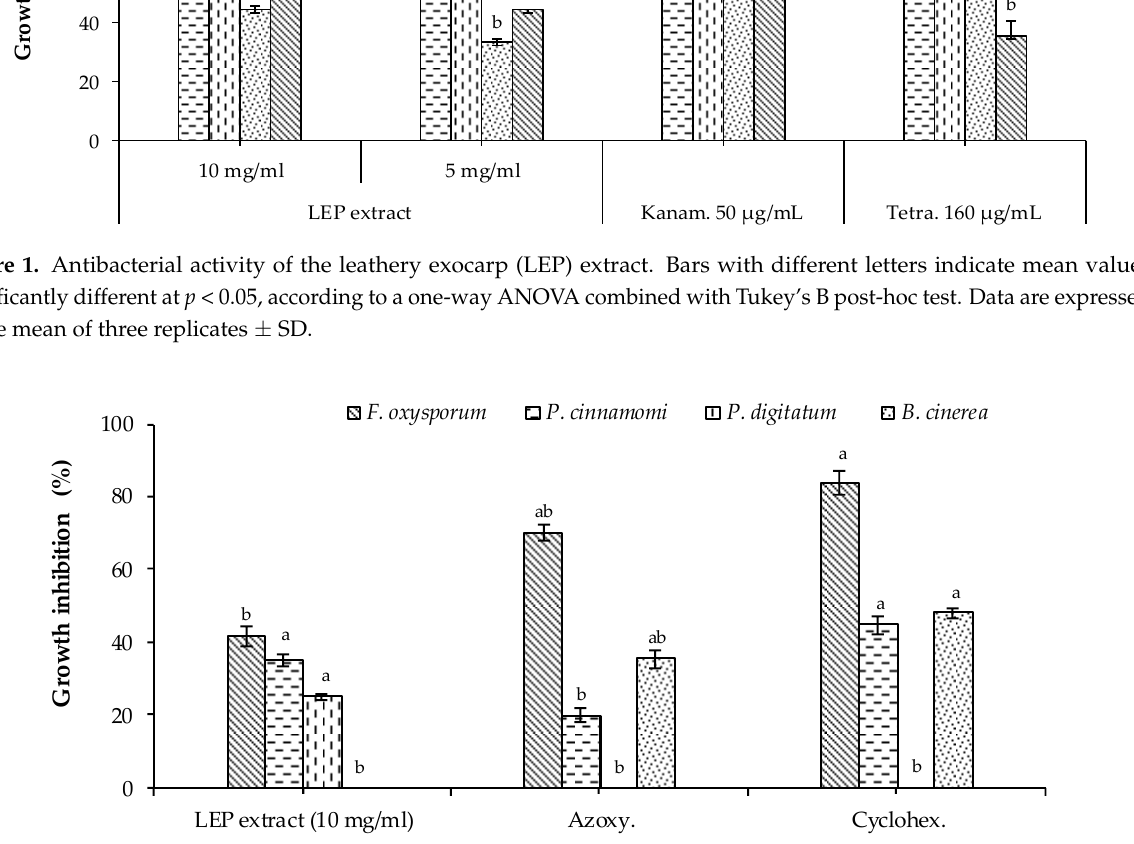
Figure 1. Antibacterial activity of the leathery exocarp (LEP) extract. Bars with different letters indicate mean values sig ‐ nificantly different at p < 0.05, according to a one ‐ way ANOVA combined with Tukey’s B post ‐ hoc test. Data are ex ‐ pressed as the mean of three replicates ± SD.